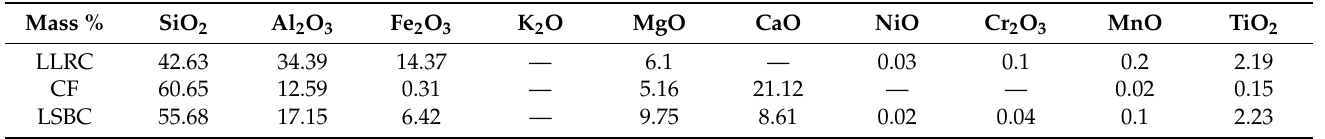
Table 2. Chemical Composition of Raw